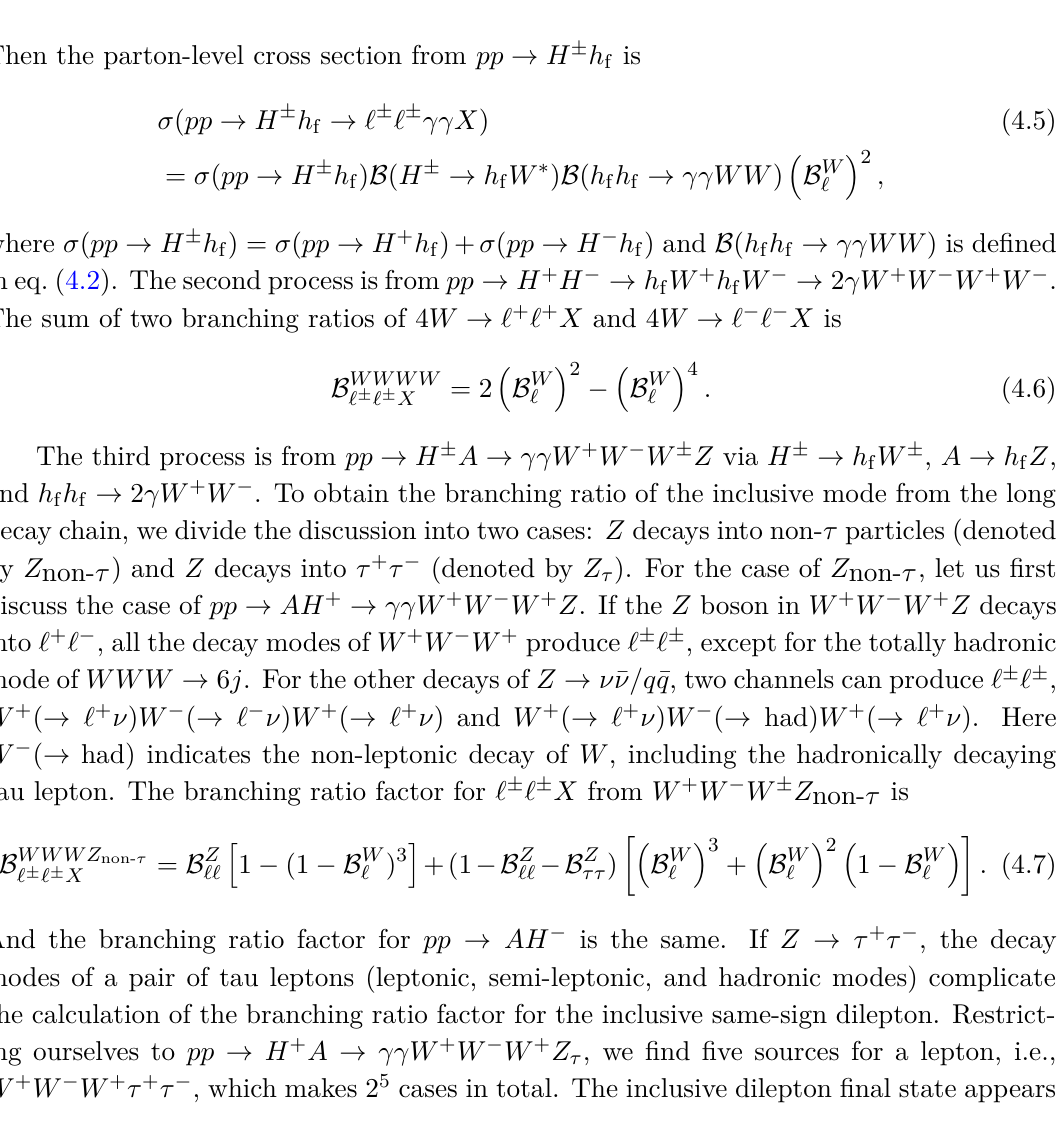
Figure 8 . The parton level cross section of σ ( pp → H ± h f → τ ± νγγ ) at the 14 TeV LHC about M for m h = 80 GeV (left), m h = 90 GeV (middle), and m h A/H ± f f code denotes t β . We present the result over the parameter points that satisfy Step A, Step B, the CDF 4 γX constraint, and Λ cut > 10 18 GeV